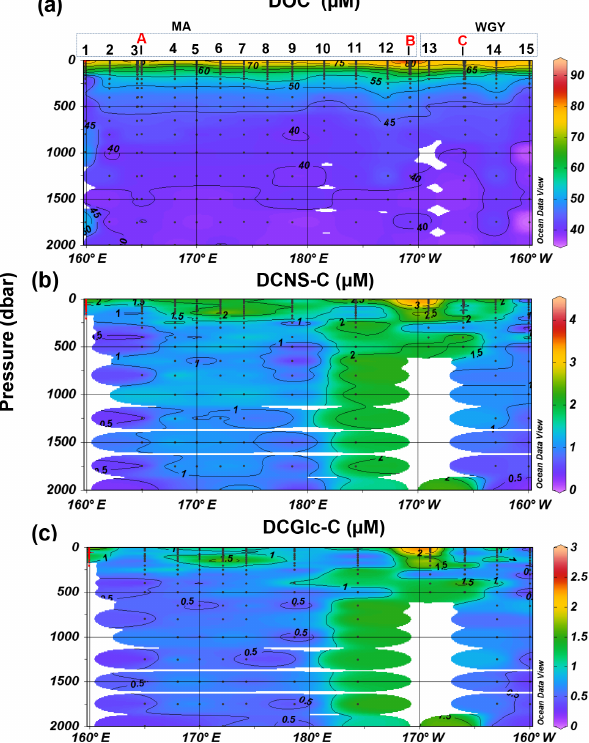
Figure 3. Distribution of (a) dissolved organic carbon (DOC), (b) dissolved combined neutral sugars (DCNS) and (c) dissolved combined glucose (DCGlc) in the upper surface layer (0–200m) of the study area. DCNS and DCGlc concentration is given in car- bon equivalents in order to have the same unit as DOC. Long- duration stations (LDA, LDB and LDC) are also indicated in each graph. White and red circles indicate the mixed layer depth and deep chlorophyll maximum, respectively, for each station.